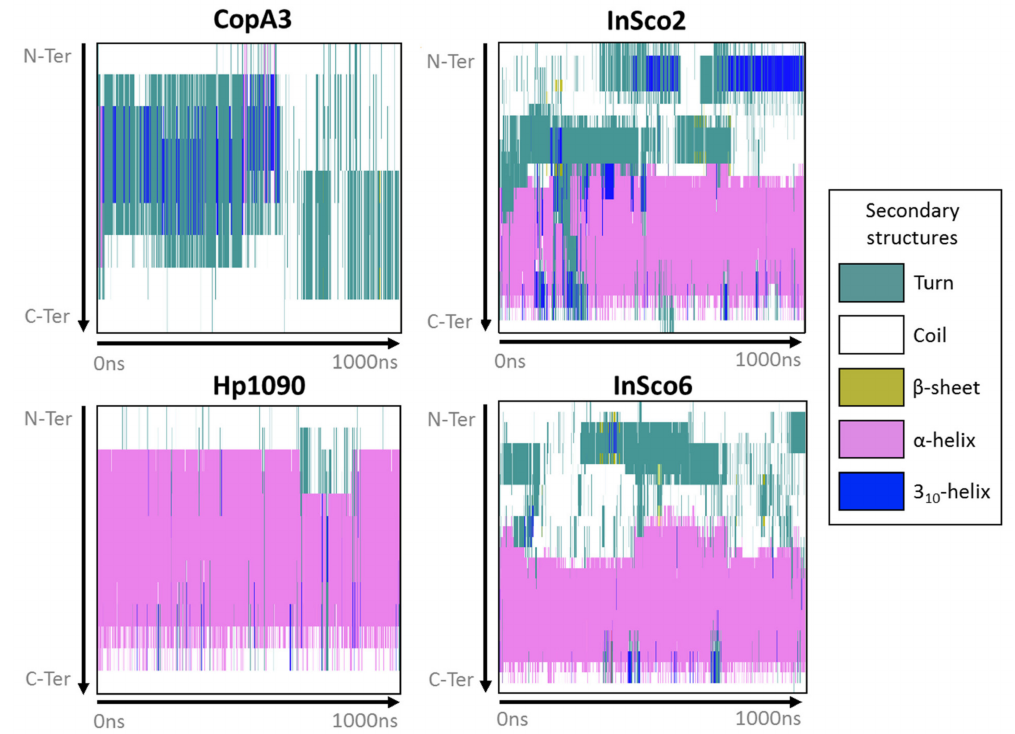
Figure 2. Secondary structure of the AMPs during membrane interactions. The panels display the secondary structures defined in the key for each antibacterial AMP from the N-terminus to the C terminus ( y -axis) during the 1- µ s molecular dynamics simulation ( x